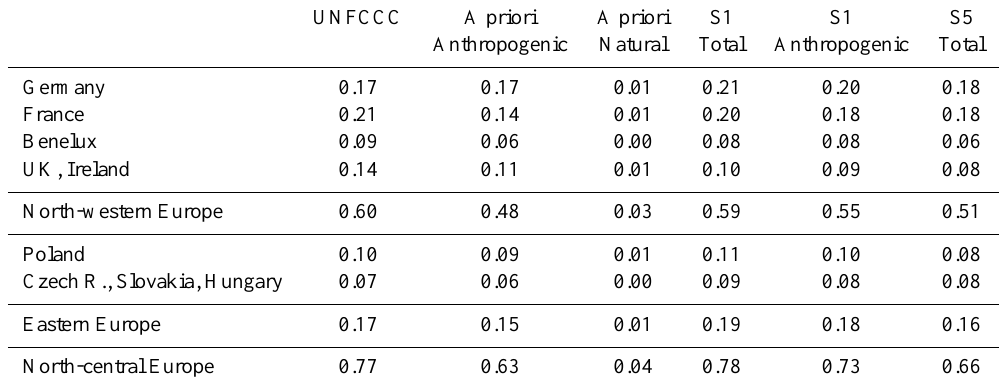
Table 5. 2006 total N 2 O emissions (Tg N 2 O/yr) for the same countries and regions shown in Fig. 5. Natural and anthropogenic emissions are separated in order to allow for a clear comparison with UNFCCC data.